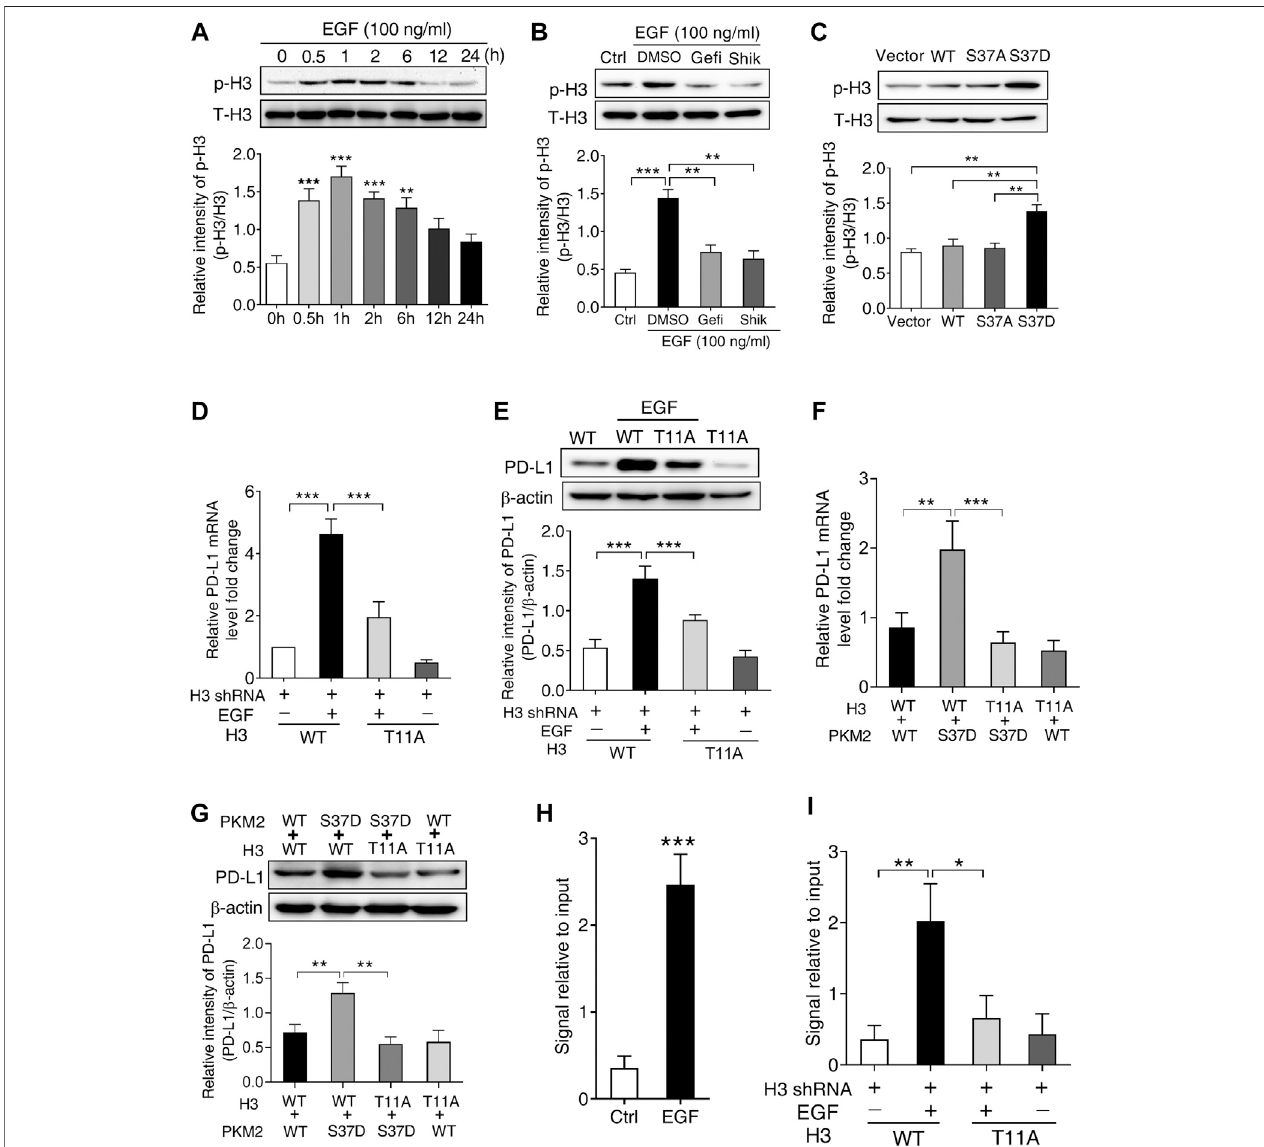
FIGURE5| PKM2-induced phosphorylationofhistoneH3atThr 11 isrequired forEGF-mediatedPD-L1 transcription inSNU-368cells. (A) EGF treatment induced a signi fi cant increase in H3 Thr 11 phosphorylation in SNU-368 cells. **p < 0.01, ***p < 0.001, one-way ANOVA, n (cid:2) 5 independent experiments per group, (B) EGF- induced H3-Thr 11 phosphorylation was attenuated by Ge fi tinib and shikonin after 1 h co-incubation in SNU-368 cells, **p < 0.01, ***p < 0.001, one-way ANOVA, n (cid:2) 5 independent experiments per group, (C) expression of the phosphorylation-mimic PKM2 S37D mutant increased H3-Thr 11 phosphorylation compared with the WT PKM2 or the S37A mutant in SNU-368 cells. **p < 0.01, one-way ANOVA, n (cid:2) 5 independent experiments per group, (D and E) Reconstituted expression of RNAi- resistant histone H3-T11A abrogated EGF-induced the mRNA, (D) , and protein (E) expression of PD-L1 in endogenous H3-depleted SNU-368 cells. At 24 h post- transfection, cells were incubated in the presence or absence of 100 ng/ml EGF for 12 h * **p < 0.001, one-way ANOVA, n (cid:2) 5 independent experiments per group (F and G) Reconstituted expression of WT histone H3 and PKM2 S37D could induce PD-L1 mRNA (F) and protein (G) expression which could be blocked when WT histone H3 was replaced with histone H3 T11 A mutant in endogenous histone H3-depleted SNU-368 cells. **p < 0.01, * **p < 0.001, one-way ANOVA, n (cid:2) 5 independent experiments per group (H) ChIP analysis showed that EGF treatment for 6 h resulted in enhanced H3-Thr 11 phosphorylation at the PD-L1 promoter in SNU-368cells. **p < 0.01, atwo-tailedunpaired t -test, n (cid:2) 5independentexperiments pergroup (I) ChIP analysisshowed reconstitutedexpression ofhistoneH3T11A mutant abrogated EGF-induced enhanced H3-Thr 11 phosphorylation at the PD-L1 promoter in endogenous histone H3-depleted SNU-368 cells.